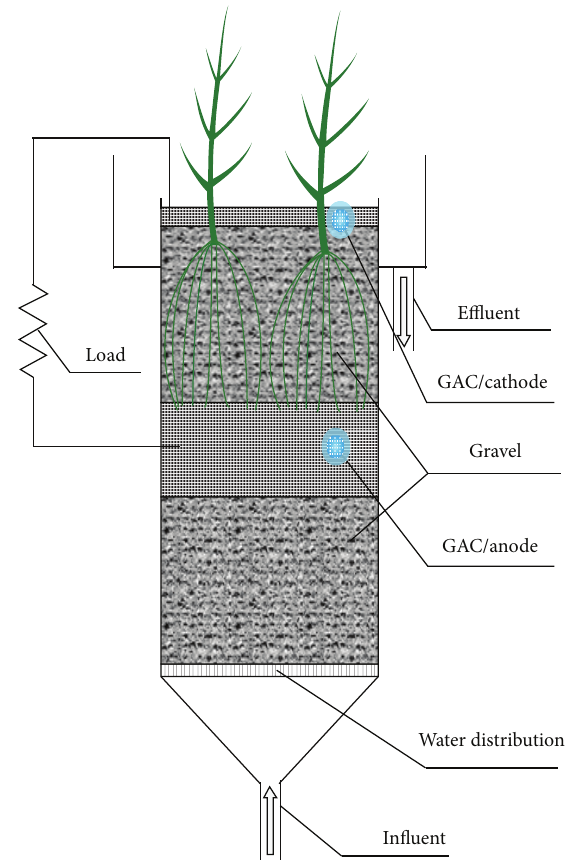
Figure 1: Schematic of the CW-MFCs used in the experiment.